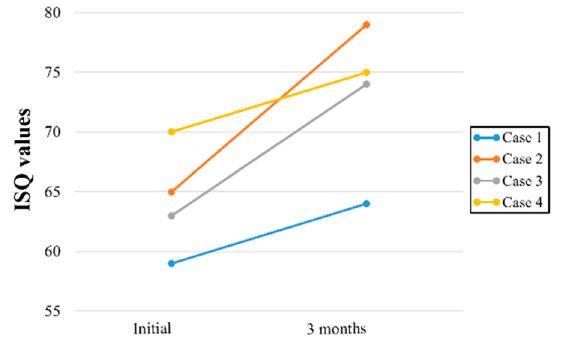
Figure 5. Implant stability quotient (ISQ) values measured using the resonance frequency analysis. Case 1 having the least remaining vertical ridge height showed the least initial stability, and vice versa for Case 4.